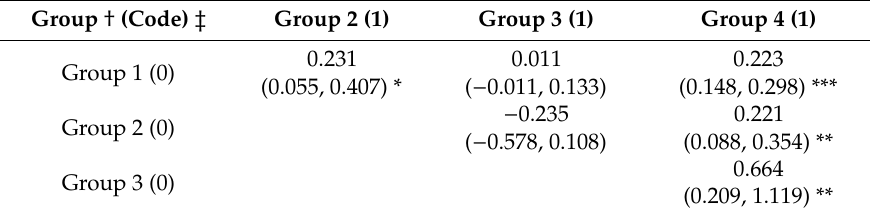
Table 3. Multiple regression models (β and 95%CI) to identify an association of the combination of race/ethnicity and type of insurance with repeat ED visits.